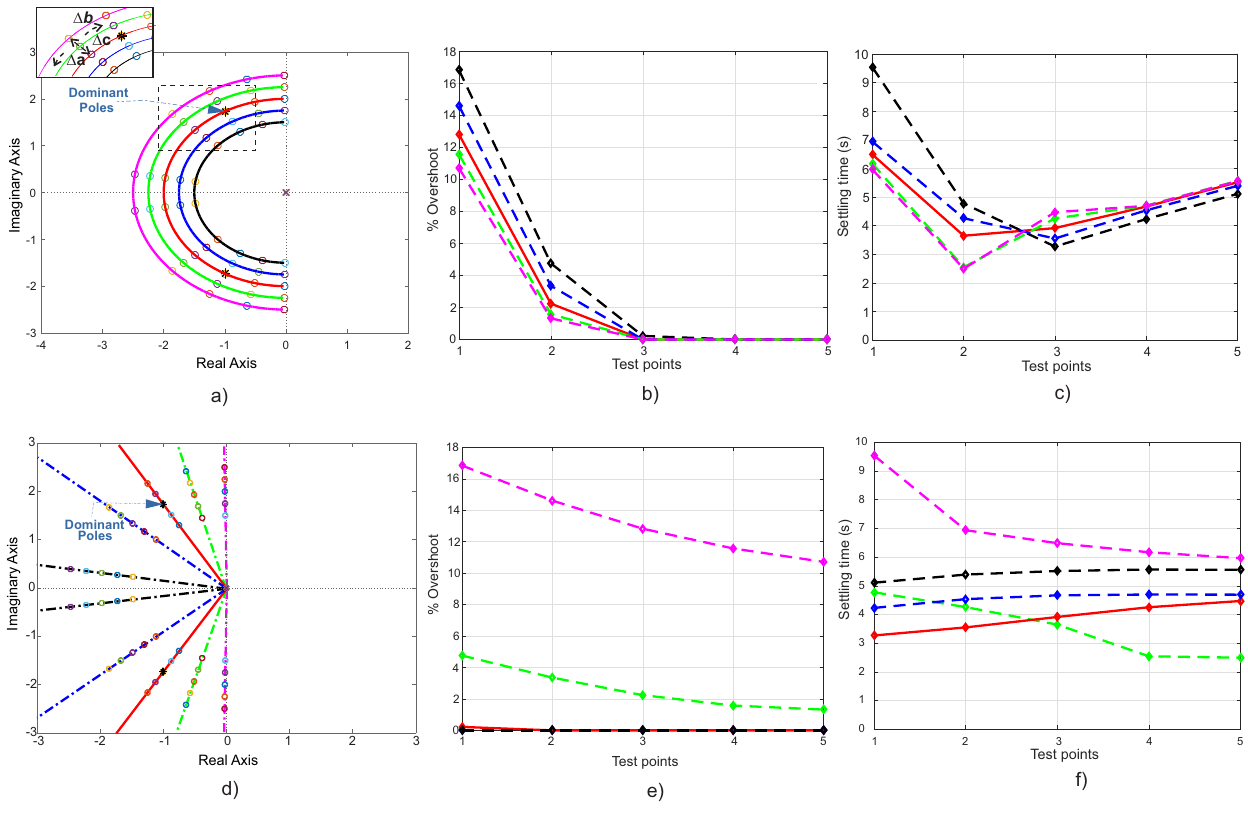
Figure 1. Analysis of the PID root behavior on Laplace plane. ( a ) Tuning plane on semicircle, ( b ) overshoot behavior on semicircle, and ( c ) settling time behavior on semicircle: central semicircle; semicircle at − 0.5; semicircle at − 0.25; semicircle at 0.25; semicircle at 0.5. ( d ) Tuning plane on straight line, ( e ) overshoot behavior on straight line, and ( f ) settling time behavior on straight line: central line; bottom line (near real axis); line between central line and bottom line; line between central and top line; top line (near imaginary axis). From (4), the factor that determines the limit between complex and real roots is b 2 − 4 ac